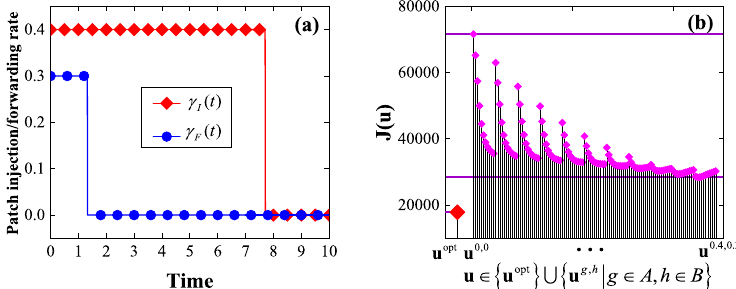
Figure 5. The experimental results in Example 1: ( a ) an optimal control, ( b ) a comparison between the optimal control and the set of static controls in terms of the energy efficiency.